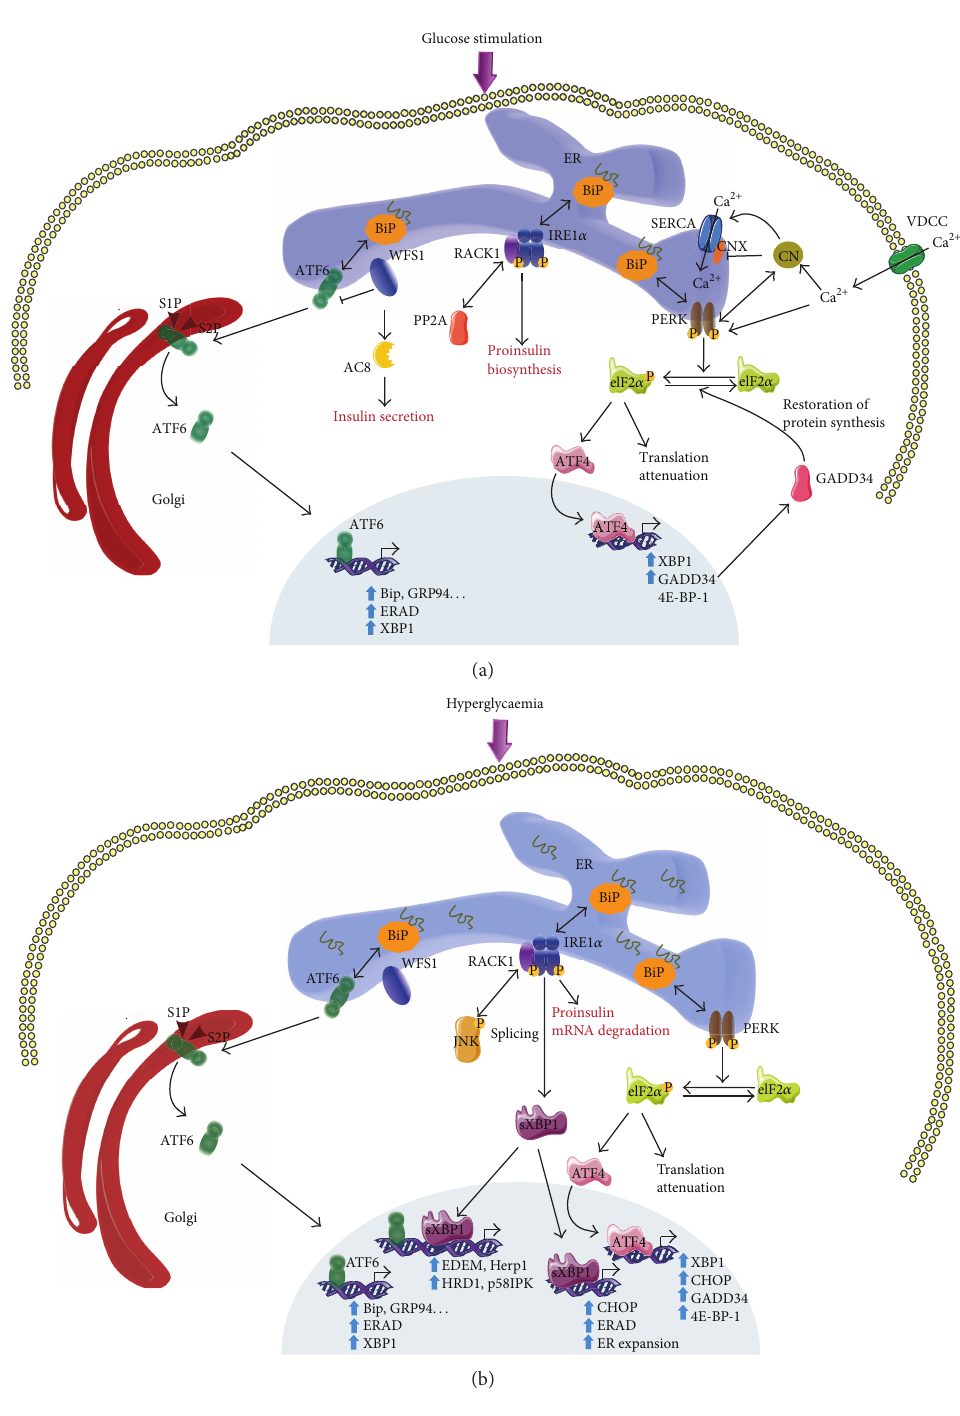
Figure 1: Physiological and physiopathological UPR activated pathways in 𝛽 cells. (a) Under physiological conditions, increased proinsulin synthesis in response to postprandial glucose activates UPR to reduce ER stress and to promote 𝛽 cell adaptation. The UPR triggers transcription of folding protein (BiP, GRP94, ... ), protein quality control (ERAD), UPR retrocontrol protein (GADD34), and attenuates protein translation (elF2 𝛼 ). Additionally, the UPR regulates calcium homeostasis via PERK, promotes proinsulin synthesis via IRE1 𝛼 , and increases insulin secretion via a WFS1-AC8 pathway. (b) Under physiopathological conditions, the UPR is hyperactivated leading to IRE1 𝛼 hyperphosphorylation, which in turn induces proinsulin mRNA degradation, JNK pathway activation, and XBP1 mRNA splicing. XBP1s alone or in synergy with ATF6 lead to expression of ER chaperon (Herp1, EDEM, HRD1, p58IPK, and ERAD) and subsequent ER expansion. Both ATF4 and sXBP1 increase CHOP mRNA expression. Under these conditions the UPR feedback is